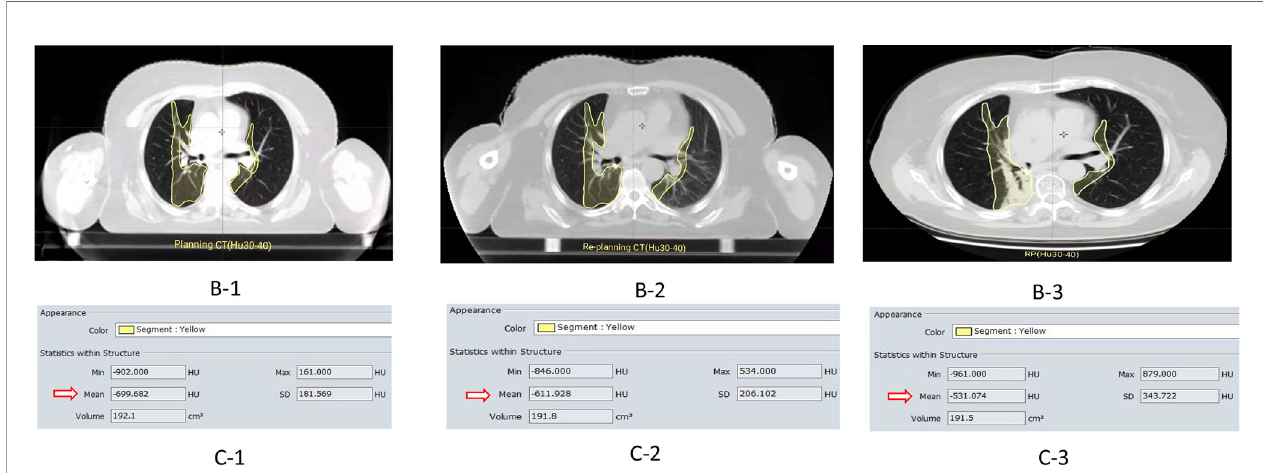
FIGURE 2 | ① B-1/-B2 represent the images of the planning CT and the re-planning CT in the HU 30-40 dose gradient(the yellow curve),respectively. B-3 is the lung image of radiation pneumonia after radiotherapy; ② C-1/C-2/C-3 represent CT density values(Hu)in the same or adjacent CT plane in planning CT, re-planning CT, and radiation pneumonia CT respectively (Hu 30-40 ); ③ For example, ( D HU: 87.754)=Planning CT (Hu:-699.682) — Re-planning (Hu:-611.928 Hu).